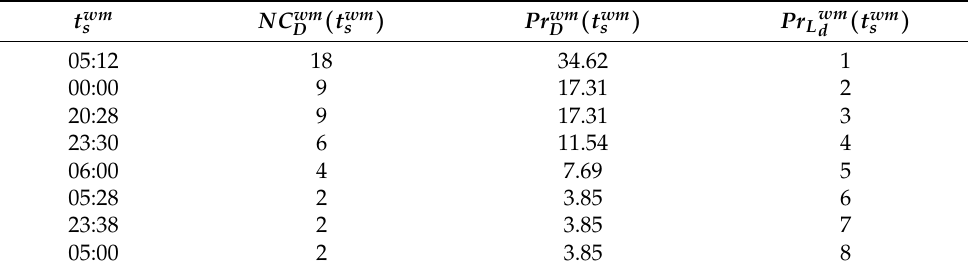
Table 4. Priority level values for t wm s